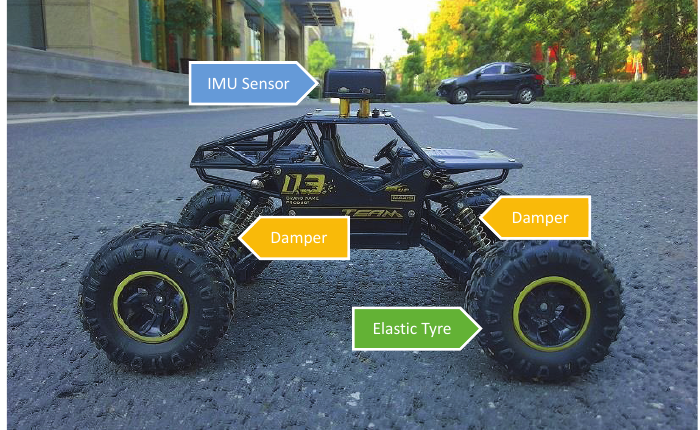
Figure 4. The experimental